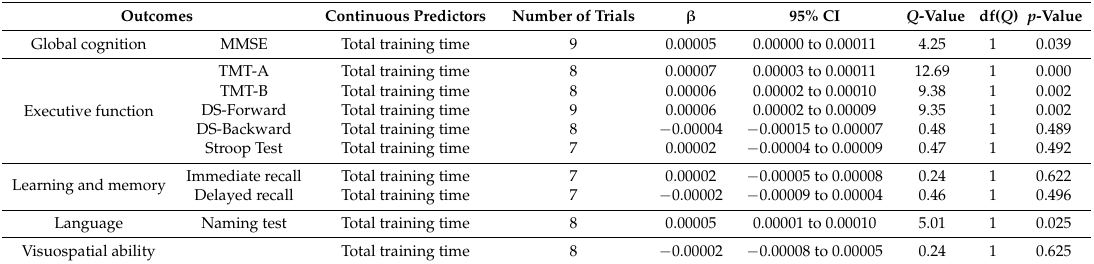
Table 5. Moderator analysis for the effects of mind-body exercise vs control intervention (continuous predictor). Outcomes Continuous